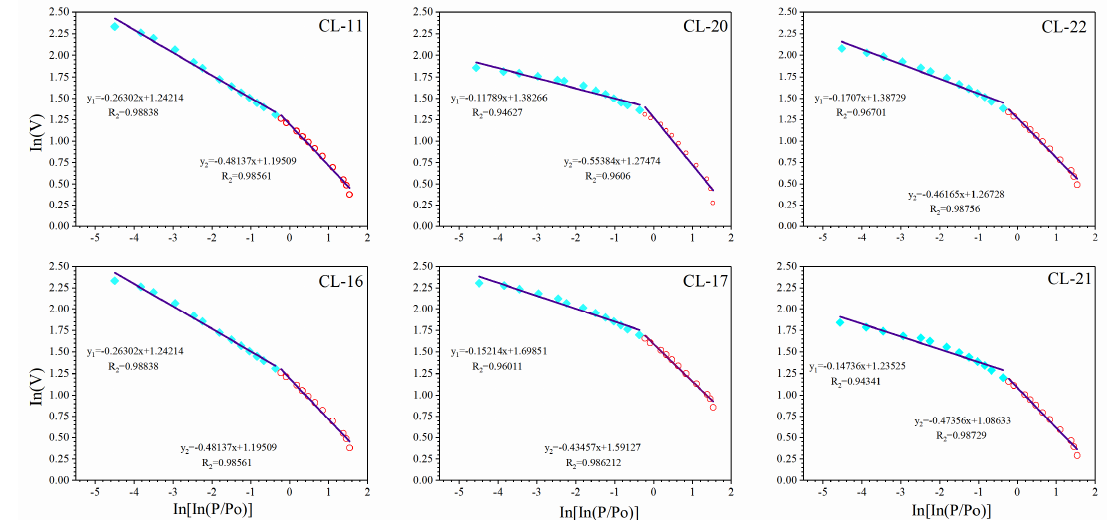
Figure 7. Plots of ln V versus ln(ln P 0 /P ) obtained from the adsorption branch of LPNP isotherms of the Shahezi shales with different lithofacies in CFD.